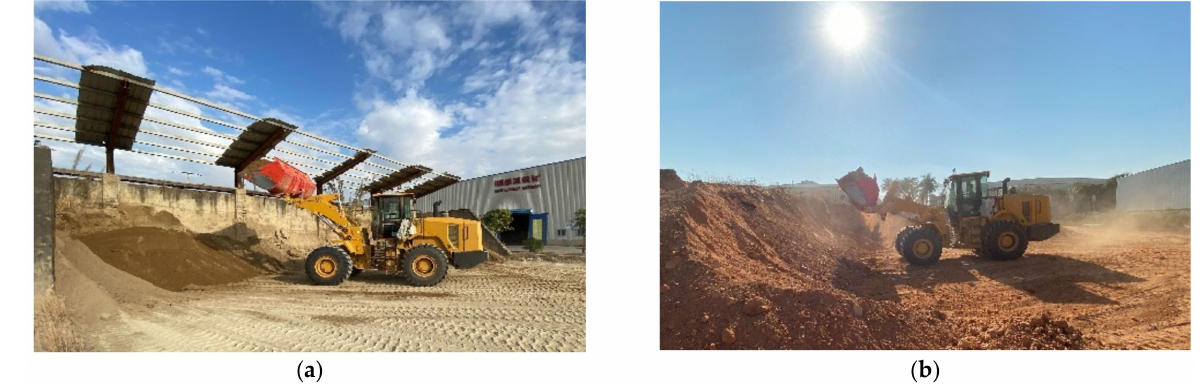
Figure 7. The operation site for data collection: ( a ) fine sand, ( b ) loose soil.